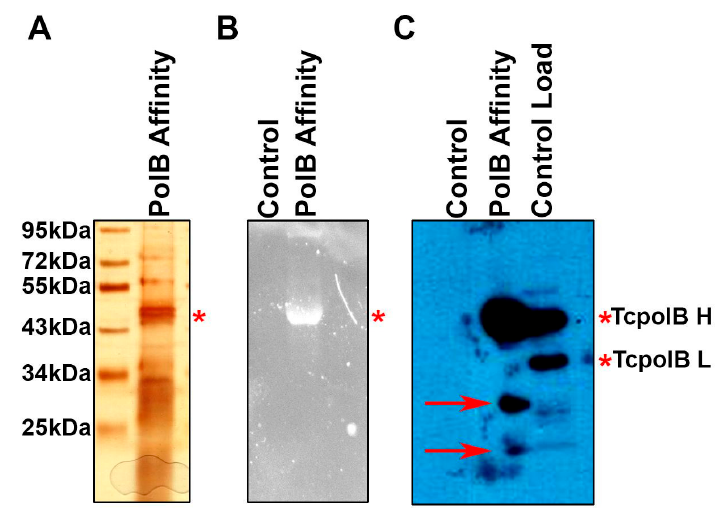
Figure 1. Purification and analysis of Tcpol β . Cell extracts from epimastigotes cells were subjected to antibody affinity chromatography and bound proteins were eluted with Glycine-HCl (pH 2.5) buffer. Eluates were concentrated using Centricon filters and subjected to SDS-PAGE (10% gel), and analyzed by silver stain ( A ), phosphoprotein staining ( B ) and western blot with anti-Tcpol β antibodies ( C ). The H and L forms of Tcpol β are indicated. Proteolytic peptides of Tcpol β are indicated by red arrows in panel ( C ). * indicate the position of TcpolB H.